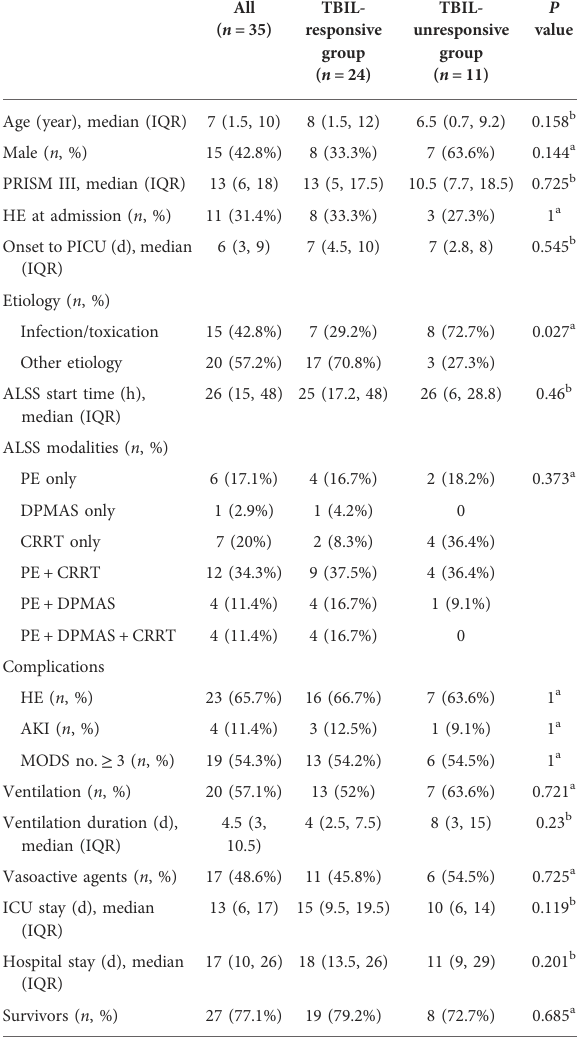
TABLE 2 Univariate analysis between the TBIL-responsive group and TBIL-unresponsive group.